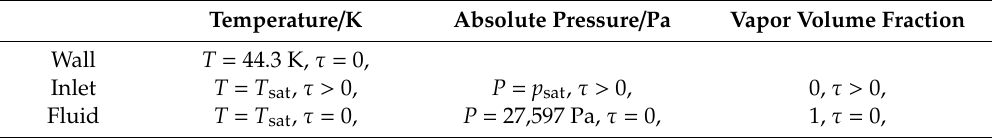
Table 2. Thermal boundary in Moran’s research